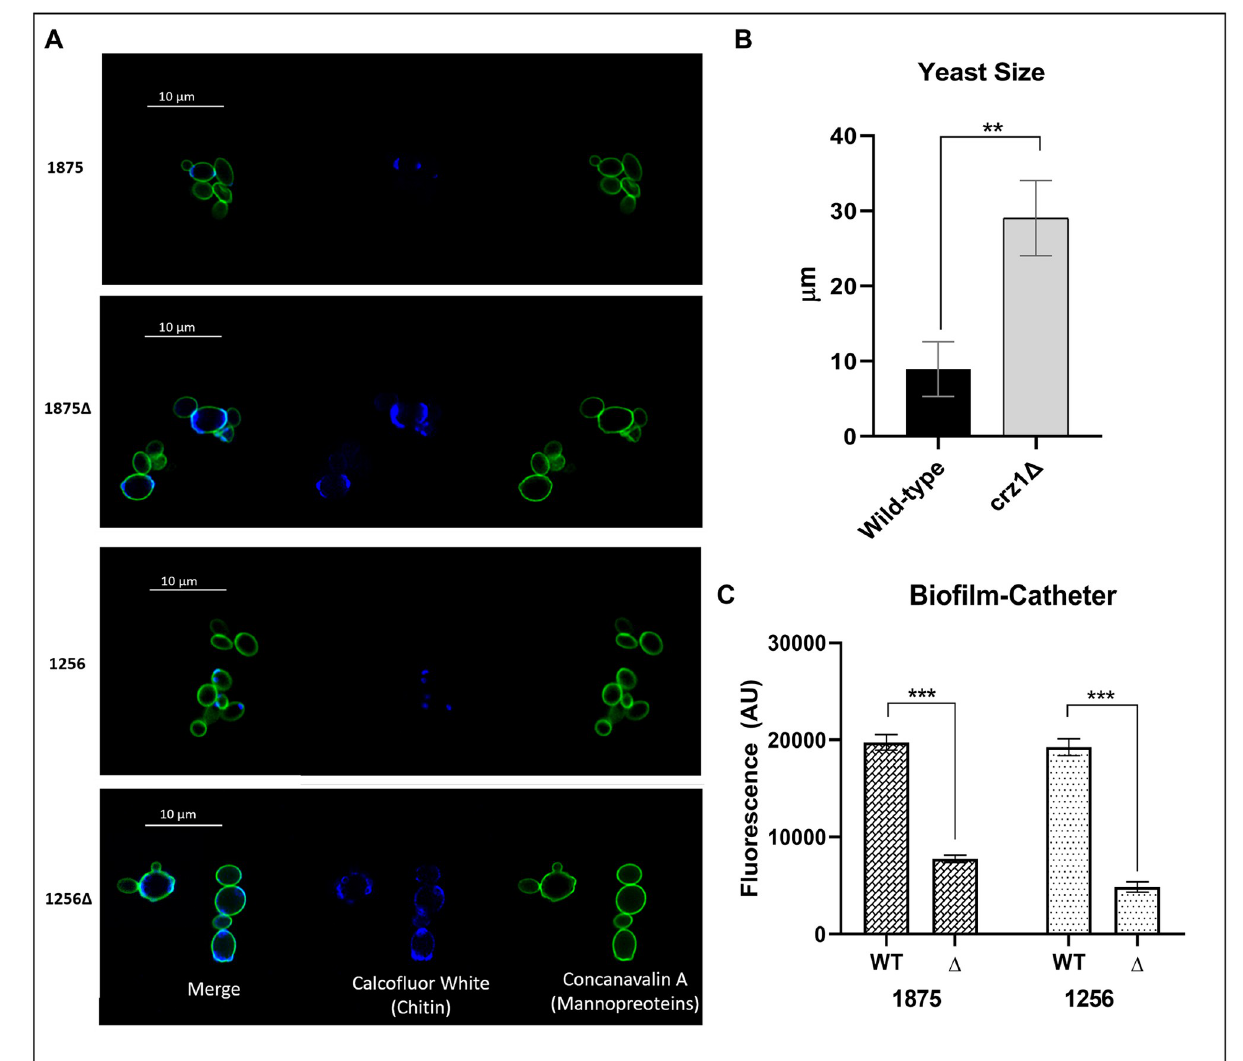
Fig 4. Confocal images and biofilm formation of C . glabrata isolates. A Yeast were stained with calcofluor white and concanavalin A conjugate for confocal scanning laser microscopy visualization. Representative images were shown. B Measurement of yeast cell size. C Biofilm formation on catheter pieces. Data is expressed as arbitrary fluorescence units. P-values of < 0.05 were used to indicate statistical significance. As follows, p < 0.05 � p < 0.02 �� and p < 0.001 ���